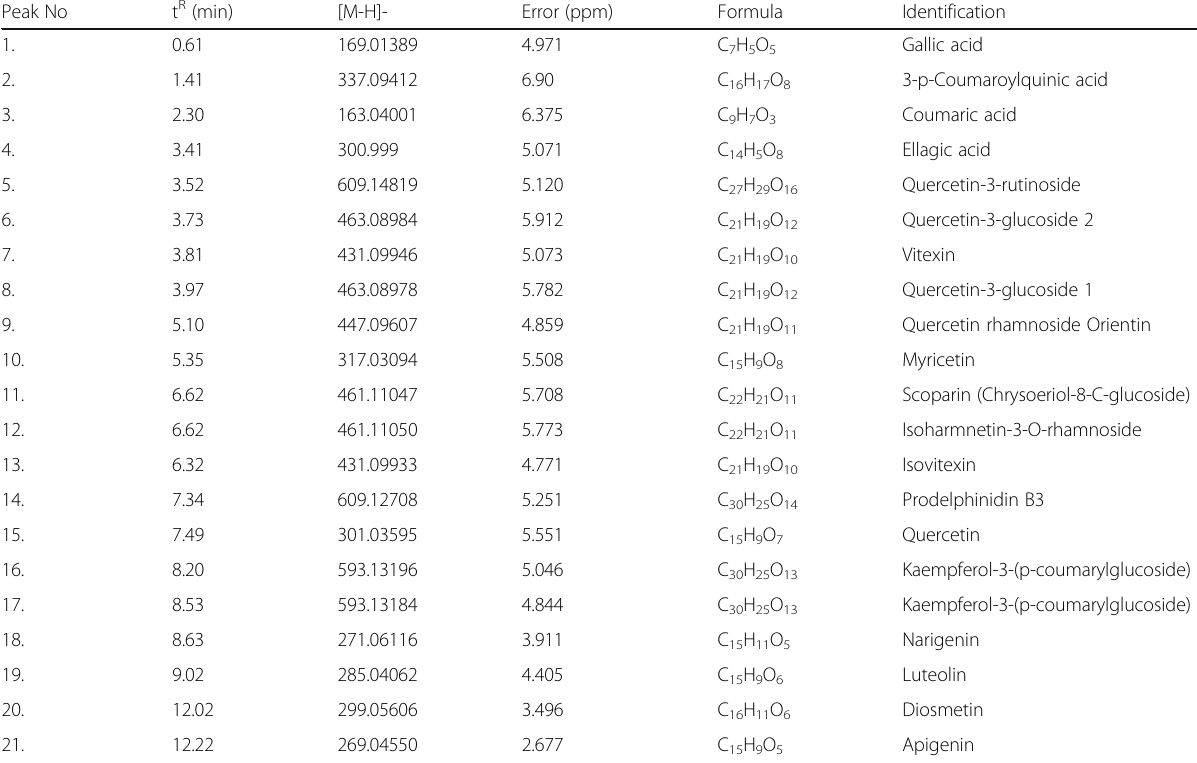
Table 5 Flavonoids and phenolic compounds identified in MMMC (ratio 1:1) using the UHPLC-ESI-MS/MS Peak No t R